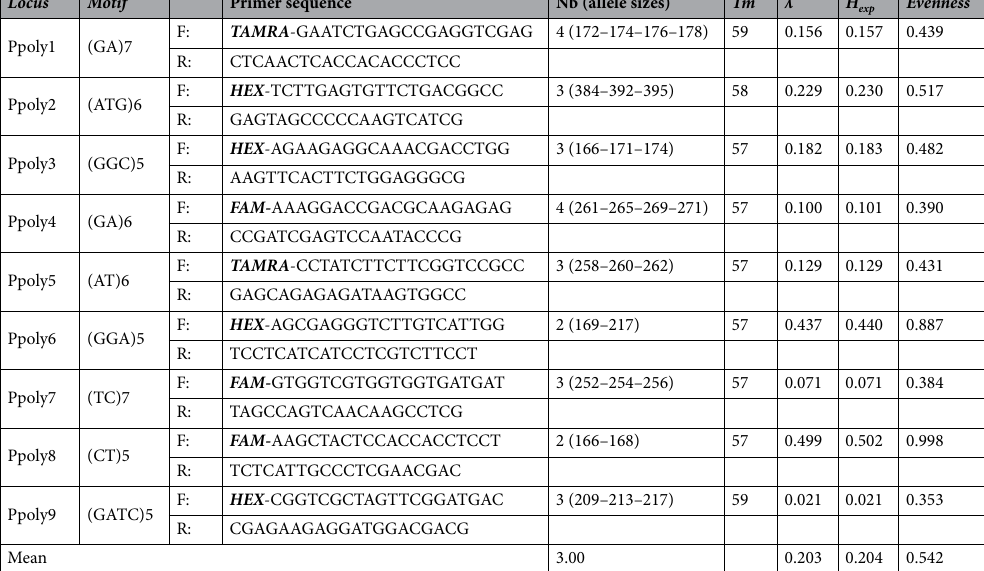
Table 4. Polymorphic microsatellite primers of P. polysora . Locus represent each SSR. Motif is the repeat motif of each SSR. F is the forward primer and R is the reverse primer of SSR. Forward primers are labeled with fluorescent tags (FAM, HEX or TAMRA). Nb ( allele sizes ) is the number of alleles. Tm represents annealing temperature. λ and H exp are diversity